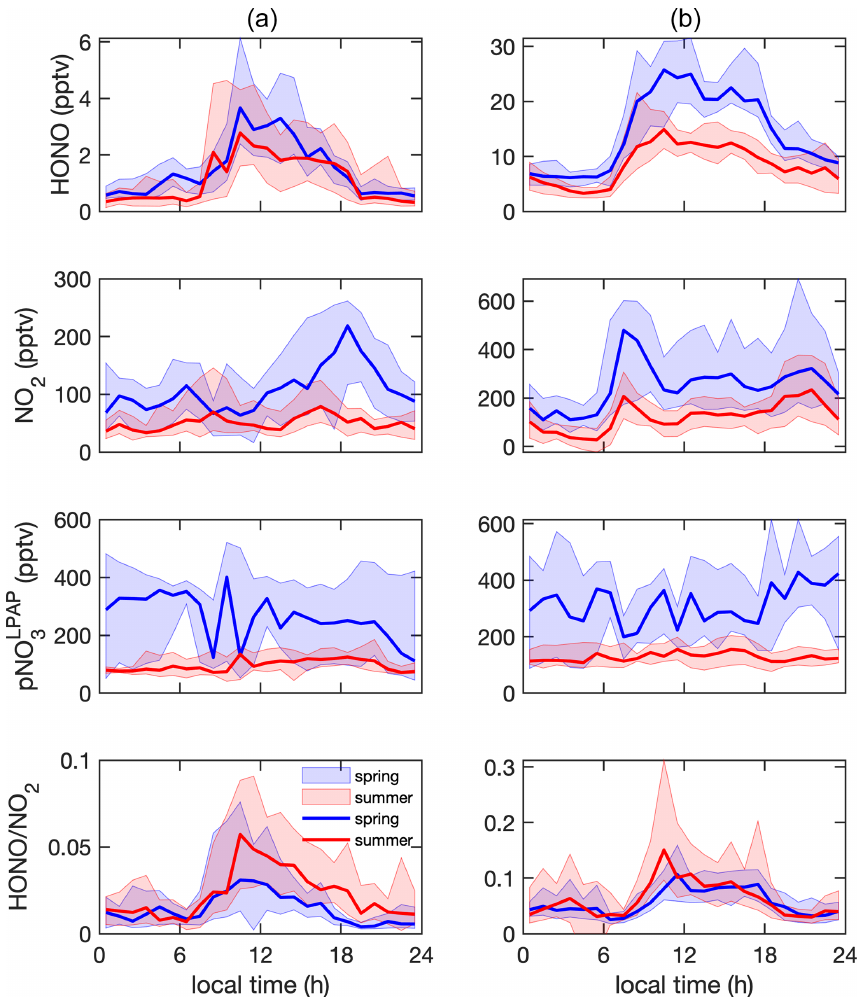
(pptv), and HONO / NO 2 ratio in (a) clean marine air and (b) island- 3